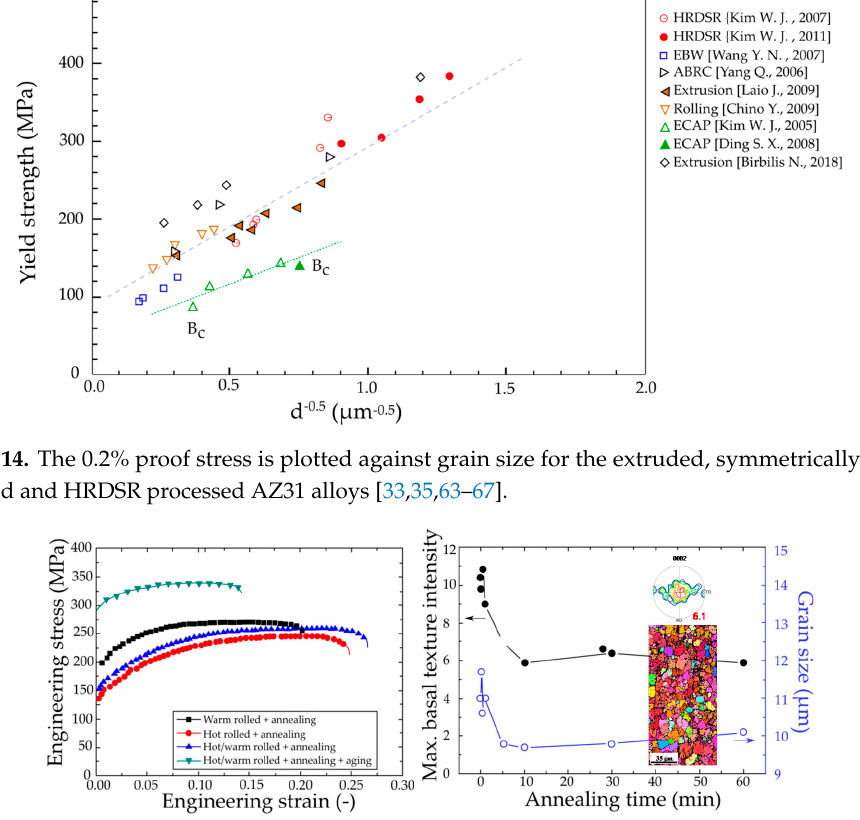
Table 1. Literature review of the mechanical properties of various alloys subjected to HRDSR compared to the as-received samples. Here, GS is the grain size, El., YS and UTS are the tensile elongation, yield strength and ultimate strength, respectively, and Hv is the Vickers hardness.